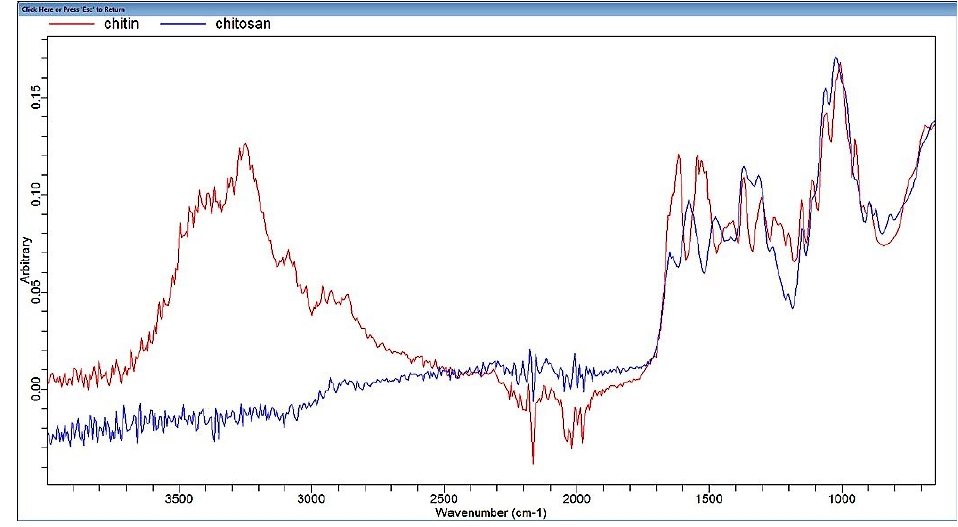
Figure 1. Infrared spectrum (FTIR) of chitin and chitosan extracted from Parapenaeus longirostris waste.